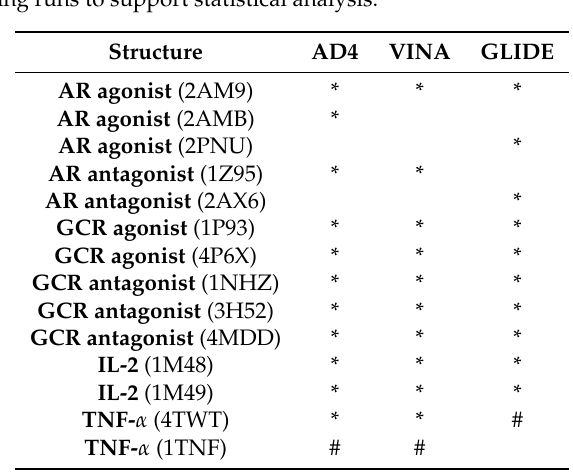
Table 2. Docking programs that succeeded/failed to produce poses within the root mean square deviation (RMSD) cutoff range of 2.0 Å. * signifies docking programs which succeeded. # indicates supplementary docking runs to support statistical